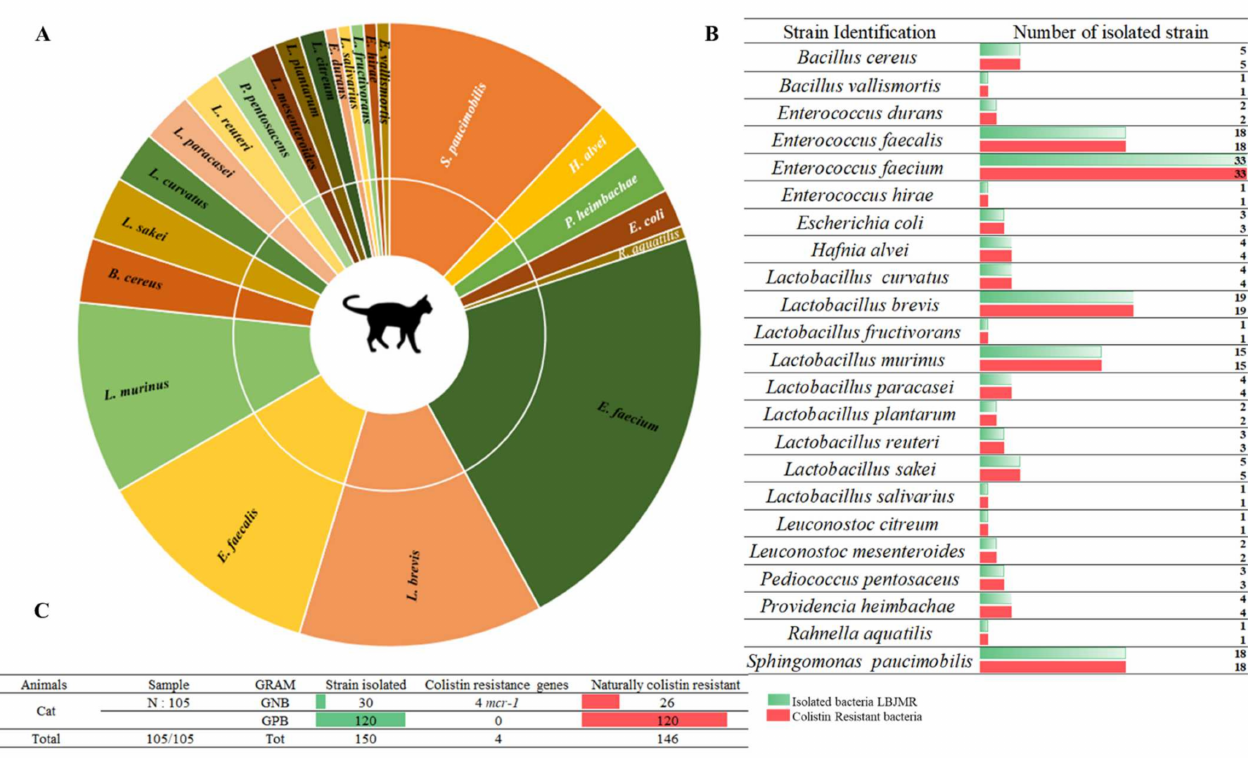
Figure 1. Proportion of colistin-resistant bacteria in feces of cats. ( A ). Pie chart representing the distribution of strains isolated in LBJMR. ( B ). Colistin-resistant bacteria verified by AST testing. ( C ). Statistical data on isolated bacteria according to Gram status and resistance